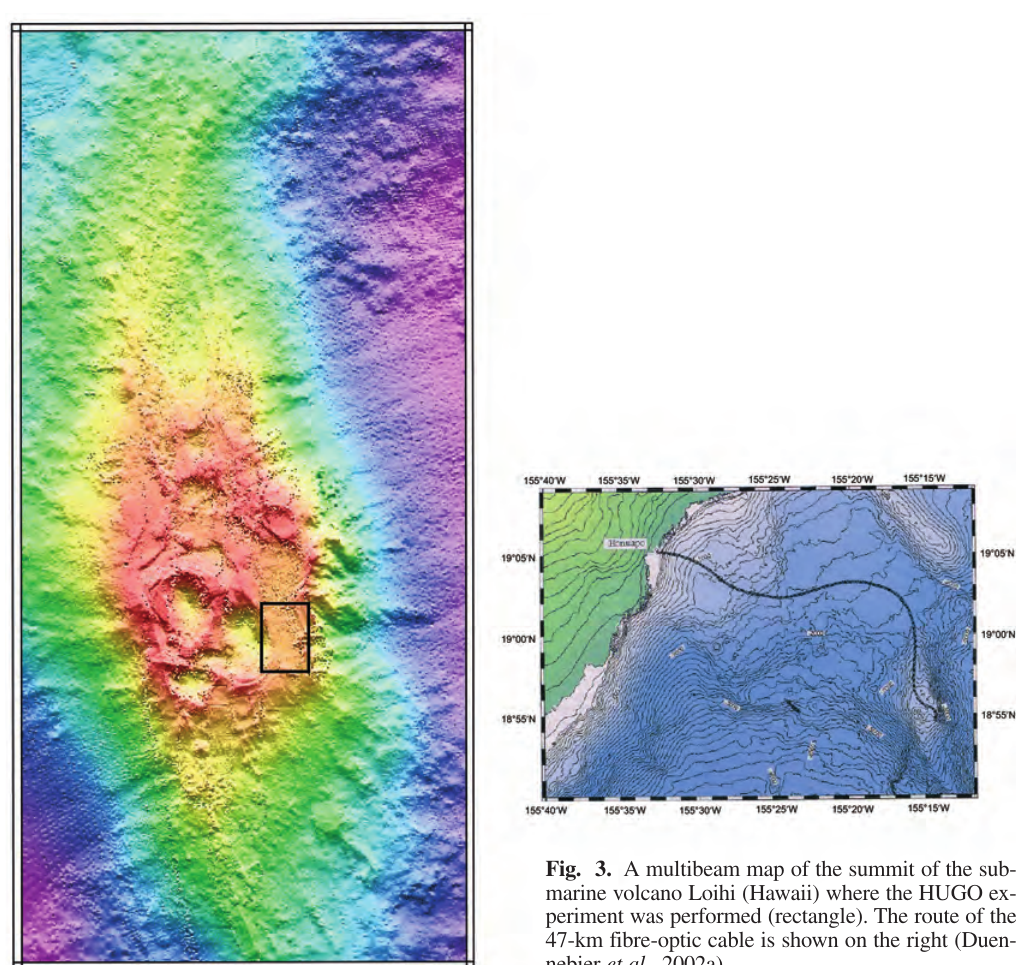
Fig. 3. A multibeam map of the summit of the sub- marine volcano Loihi (Hawaii) where the HUGO ex- periment was performed (rectangle). The route of the 47-km fibre-optic cable is shown on the right (Duen- nebier et al. ,